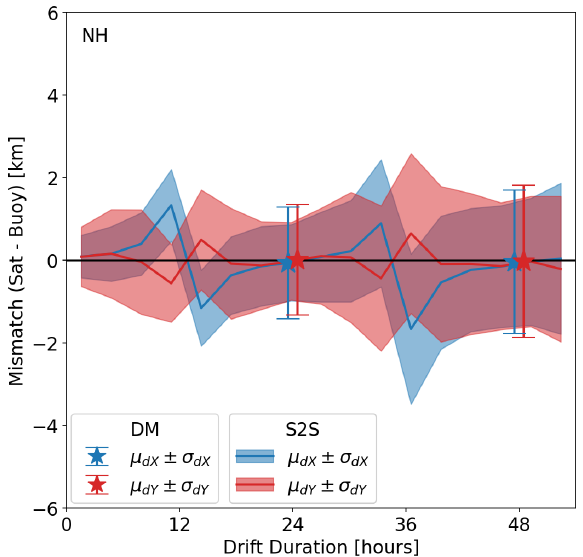
Figure 7. Same as Fig. 5a but for the case when the 36.5GHz im- agery is purposely misregistered to the location of the 18.7GHz imagery.